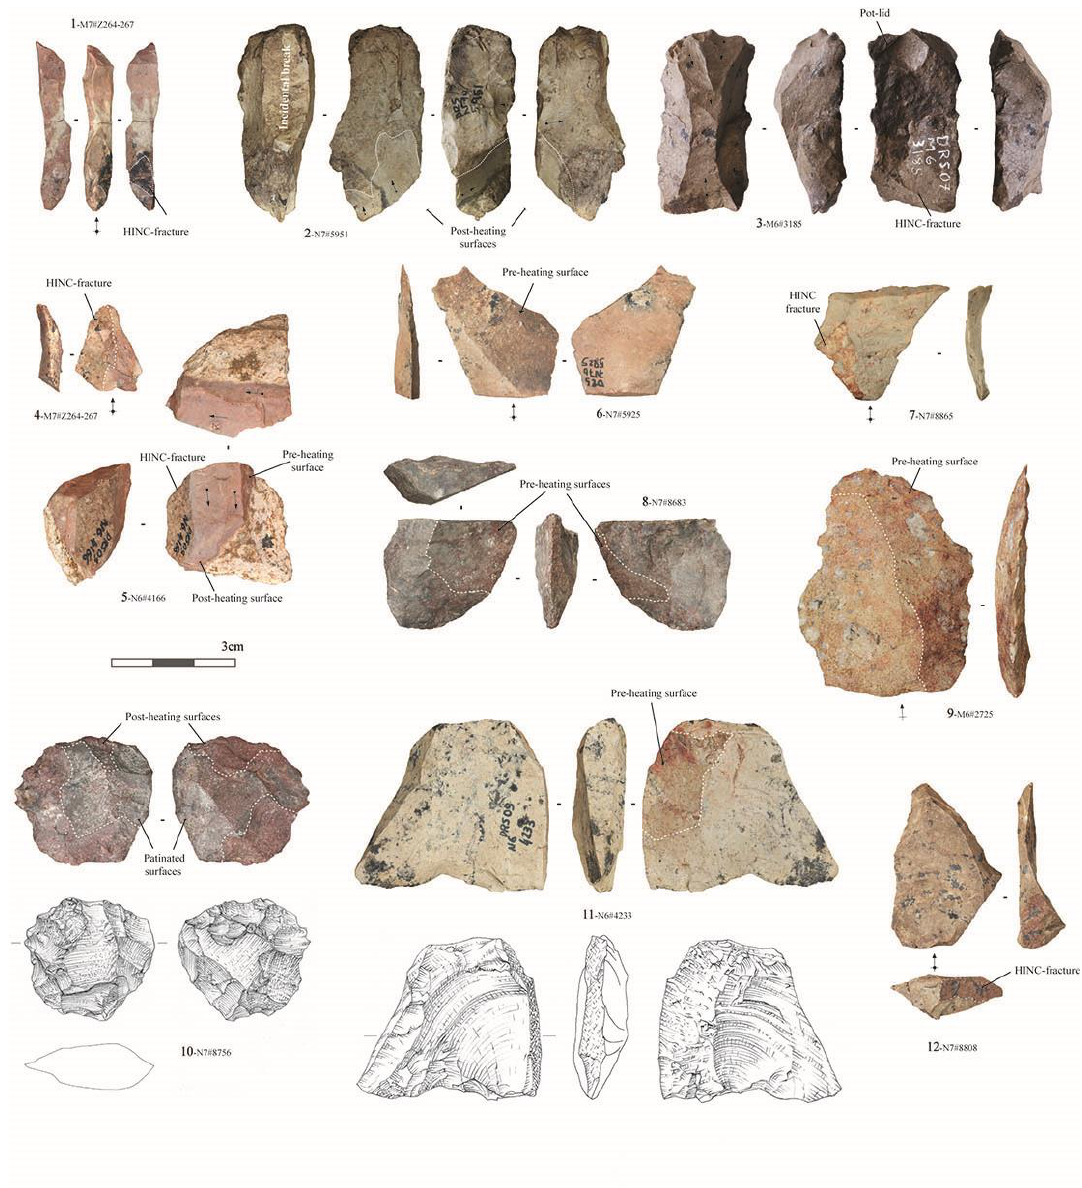
Figure 6 . Heat-treated silcrete artefacts from the stratigraphic unit Lynn at Diepkloof Rock Shelter. N°1: crested bladelet (the black deposit overlapping the HINC-fracture is post-depositional). N°2: preformed bladelet core. N°3, 5: bladelet cores. N°4, 6, 7, 9: flakes. N°8, 11: bipolar cores. N°10: Levallois core. N°12: “dos limité” flake. All exotic silcrete except n°9 (local silcrete). Notice that n°3 and 4 belong to one similar pinkish marbled yellow silcrete. (Drawings Michel Grenet). A high resolution version of this figure is available at